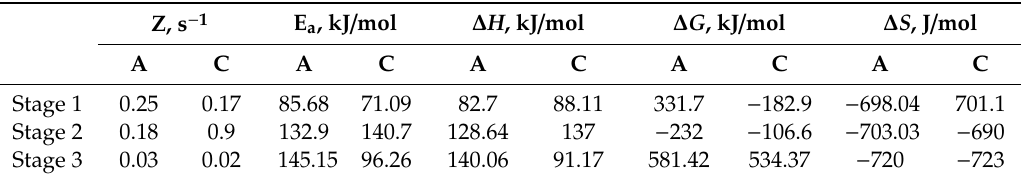
Table 2. Kinetic and thermodynamic parameters of the decomposition reaction of copper trimesinate synthesized according to methods A and C.